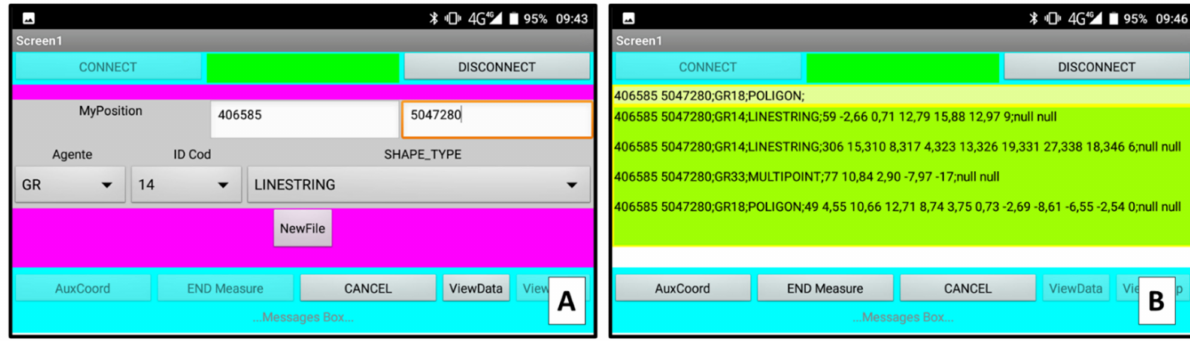
Figure 9. MARVIN Android App ( A ) setup screen and ( B ) measure screen.